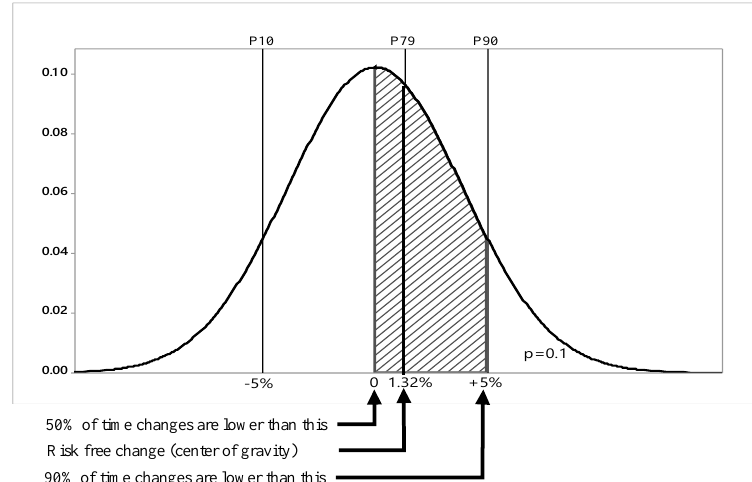
Figure 5. The normal distribution plot of changes in expenditures, Mean=0, σ=3.901